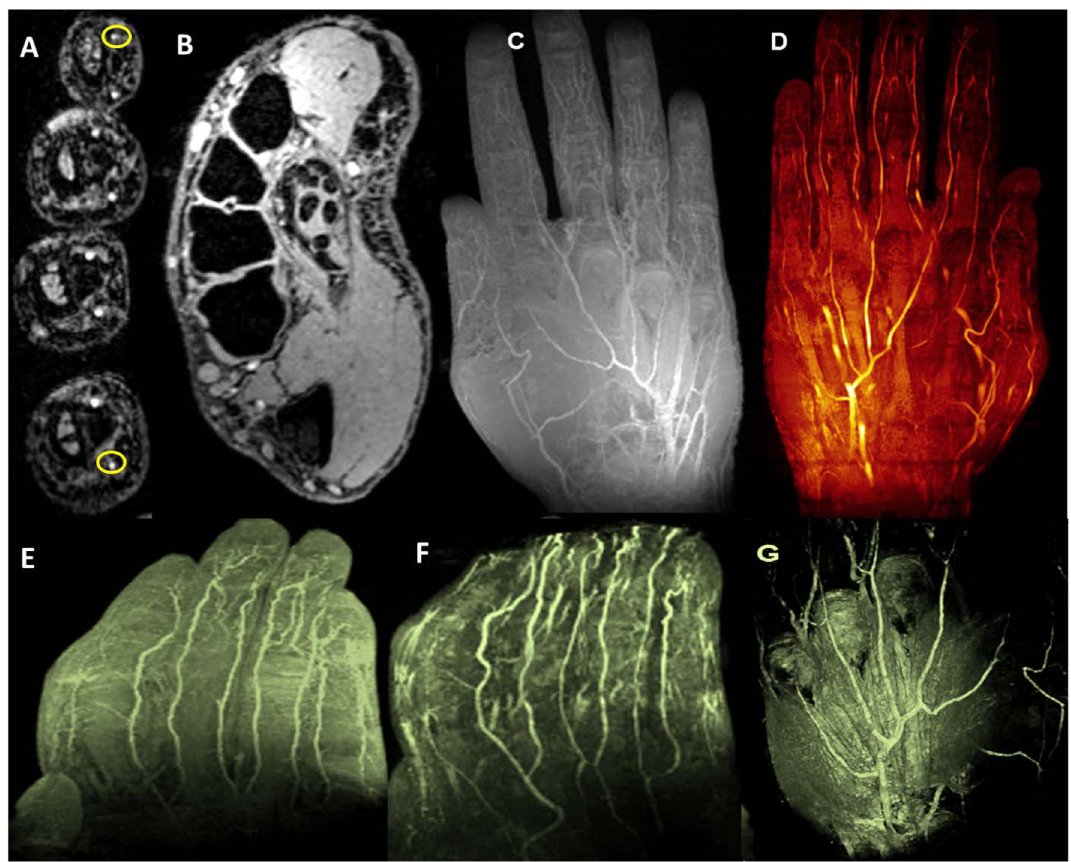
Fig 8. 7T TOF and T1 VIBE: A [TOF] demonstrates eight proper palmardigital arteries [two of them are yellow circled], digital tendons and synovialsheaths on axial view and B [T1 VIBE] shows proper palmerarteries and two proper palmer digital arteries in thumb, and cross-sectional transmetacarpal view highlightingintrinsic muscles, flexor digitorum superficialisand profundustendonsapparatuswith synovialsheaths, ligamentous structures, and inter-metacarpal vasculature. C demonstrates multipleintensity projection[MIP] of hand vasculature and [D, E and F] represent non-contrast enhancedMR angiographic images of palmar and digital microvasculature in the hand. G demonstrates 3D view of volume renderingtexture